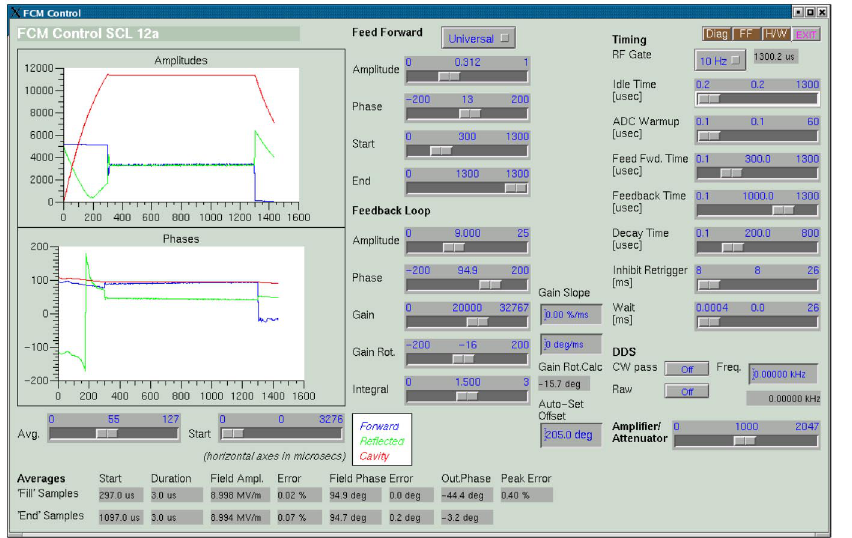
FIG. 15. (Color) Current operation method of the FCM for cavity filling and field